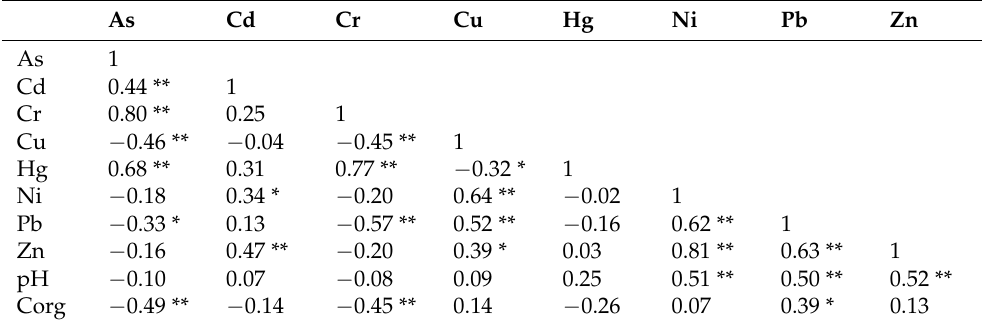
Table 4. Pearson’s correlation analysis of heavy metal elements and basic physical and chemical properties of soil in the non-karst area.